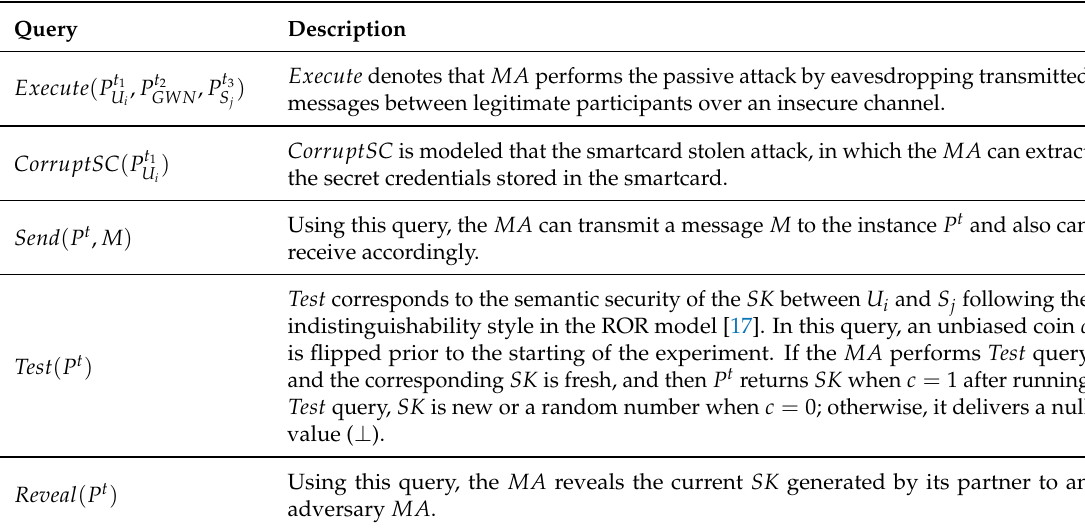
Table 4. Queries of the Real-or-Random (ROR)